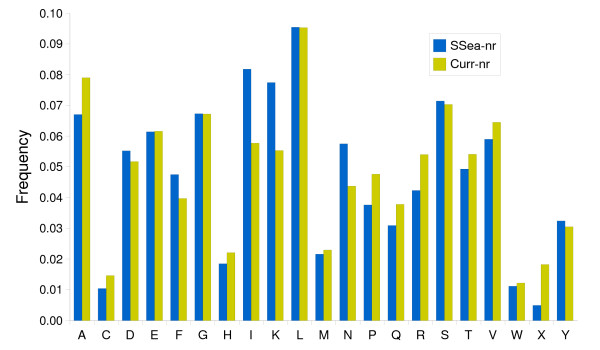
Mean amino acid composition of the current database and the Sargasso Sea resource. Bars in blue represent the proportion of each residue in the SSea-nr database, those in yellow show the corresponding distribution for the Curr-nr sequence database.